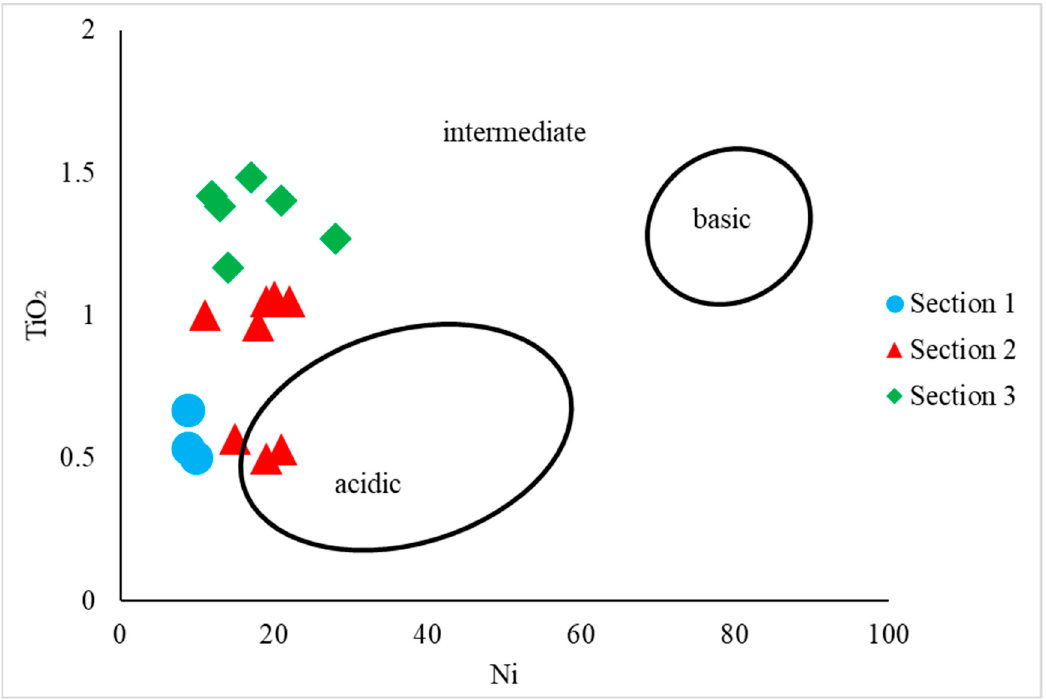
Figure 5. Diagram illustrating provenance, bivariate diagram of TiO 2 wt% vs. Ni (ppm).